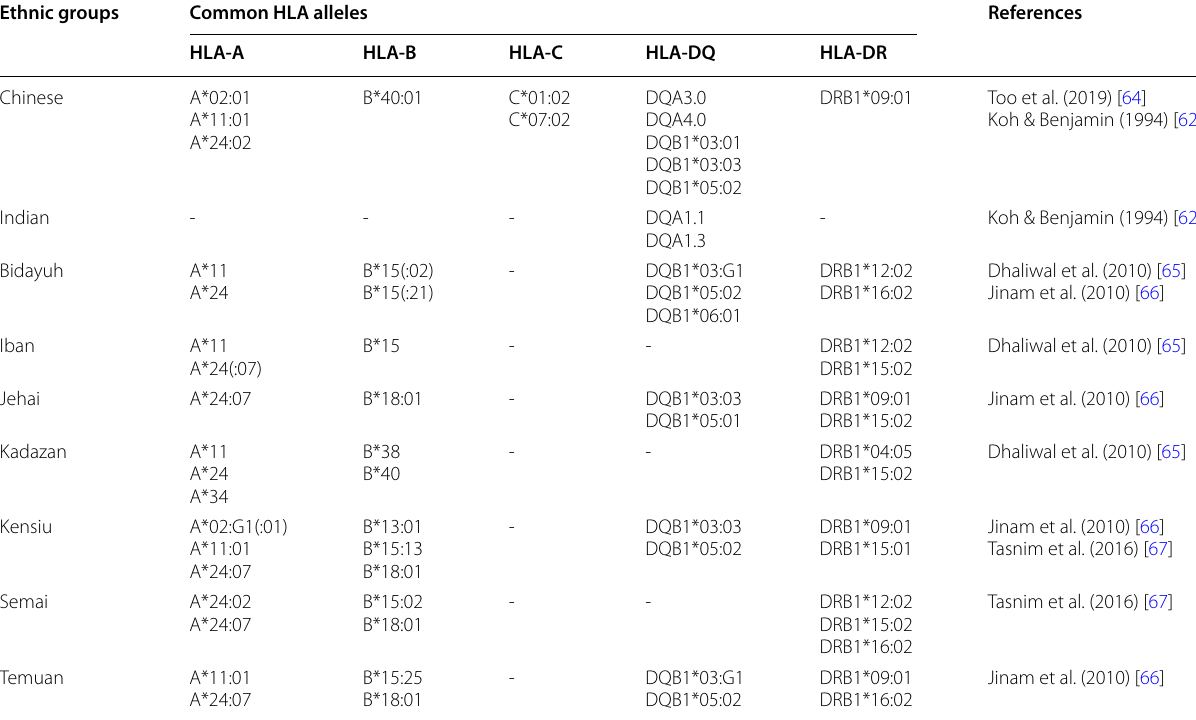
Table 4 Common HLA alleles among non-Malays and various indigenous populations in Malaysia Ethnic